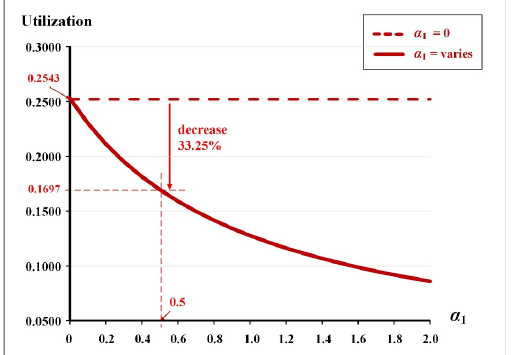
Fig. 13. The impact of α 1 on utilization Fig. 14. The investigative outcome of the influence of π